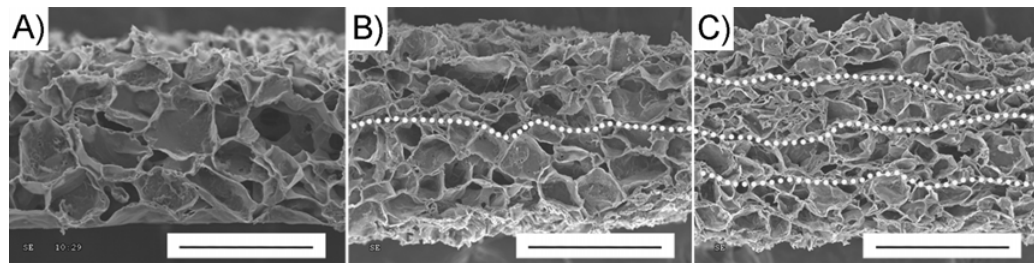
Figure 1. Representative SEM image cross-sections (a) single CUPE 1.2 scaffold sheet (scale bar = 150 μ m), (b) two CUPE 1.2 scaffold sheets crosslinked together (scale bar = 300 μ m), and (c) 4 CUPE 1.2 scaffold sheets crosslinked together (scale bar = 600 μ